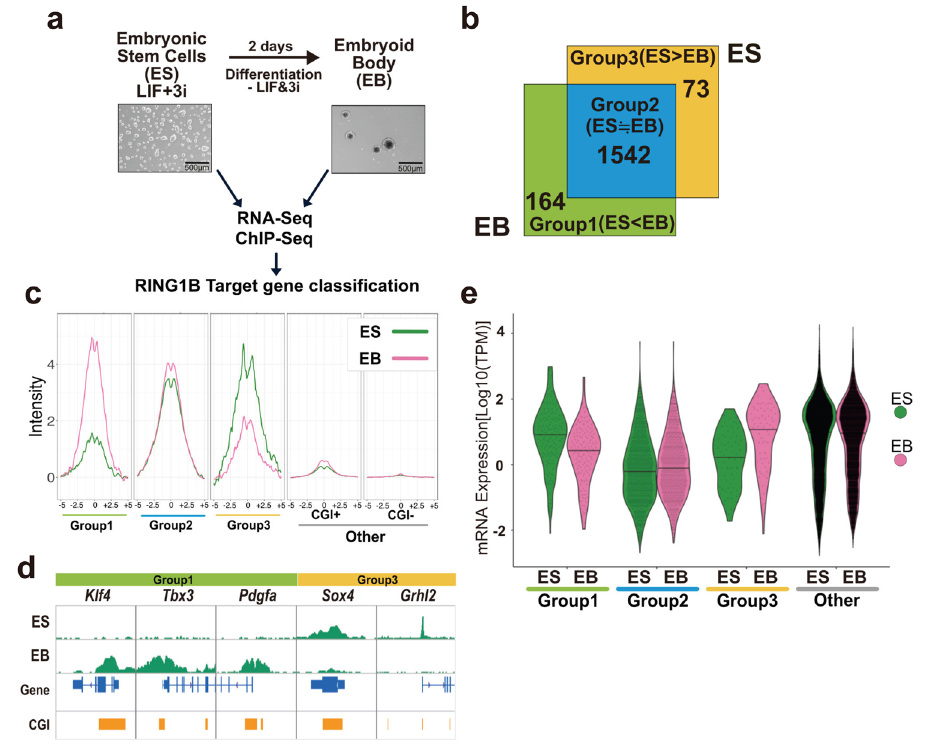
Fig. 1 Differentiation-associated accumulation of RING1B binding at Group 1 genes takes place in association with downregulation of gene expression. a Overview of the experimental design to identify genes that are downregulated during ESC-to-EB differentiation and bound by RING1B. Representative colony morphologies for ESCs and EBs are also shown. Experiments were repeated independently at least 2 times with the same results. b Identi fi cation of genes at which RING1B binding changes during ESC-to-EB transition. The number of genes in each category is shown in the Venn diagram. Genes bound by RING1B are classi fi ed into “ Group1 ” (Log2FC[EB/ES] > 1)., “ Group2 ” ( − 1 ≤ Log2FC[EB/ES] ≤ 1) or “ Group3 ” (Log2FC[EB/ES] < − 1), and are indicated by green, blue and yellow, respectively. c Average binding of RING1B in each group in ESCs and EBs. Metaplot views of RING1B binding at TSS ± 5 kb at each gene group are shown. Genes not bound by RING1B in both ESCs and EBs are further divided into CGI + (associated with CGIs) or CGI- (not associated with CGIs). Data from ESCs or EBs are indicated by green or pink lines, respectively. d Binding of RING1B at selected Group1 genes ( Klf4 , Tbx3 , Pdgfa ), and Group3 genes ( Sox4 , Grhl2 ), in ESCs and EBs. Snapshots of RING1B distributions in the ESCs and EBs are shown. Gene structures and positions of CpG islands (CGI) are indicated at the bottom. e Changes in the expression of genes differentially bound by RING1B during ESC-to-EB differentiation. Violin plot shows of the expression of genes in each group, in ESCs and